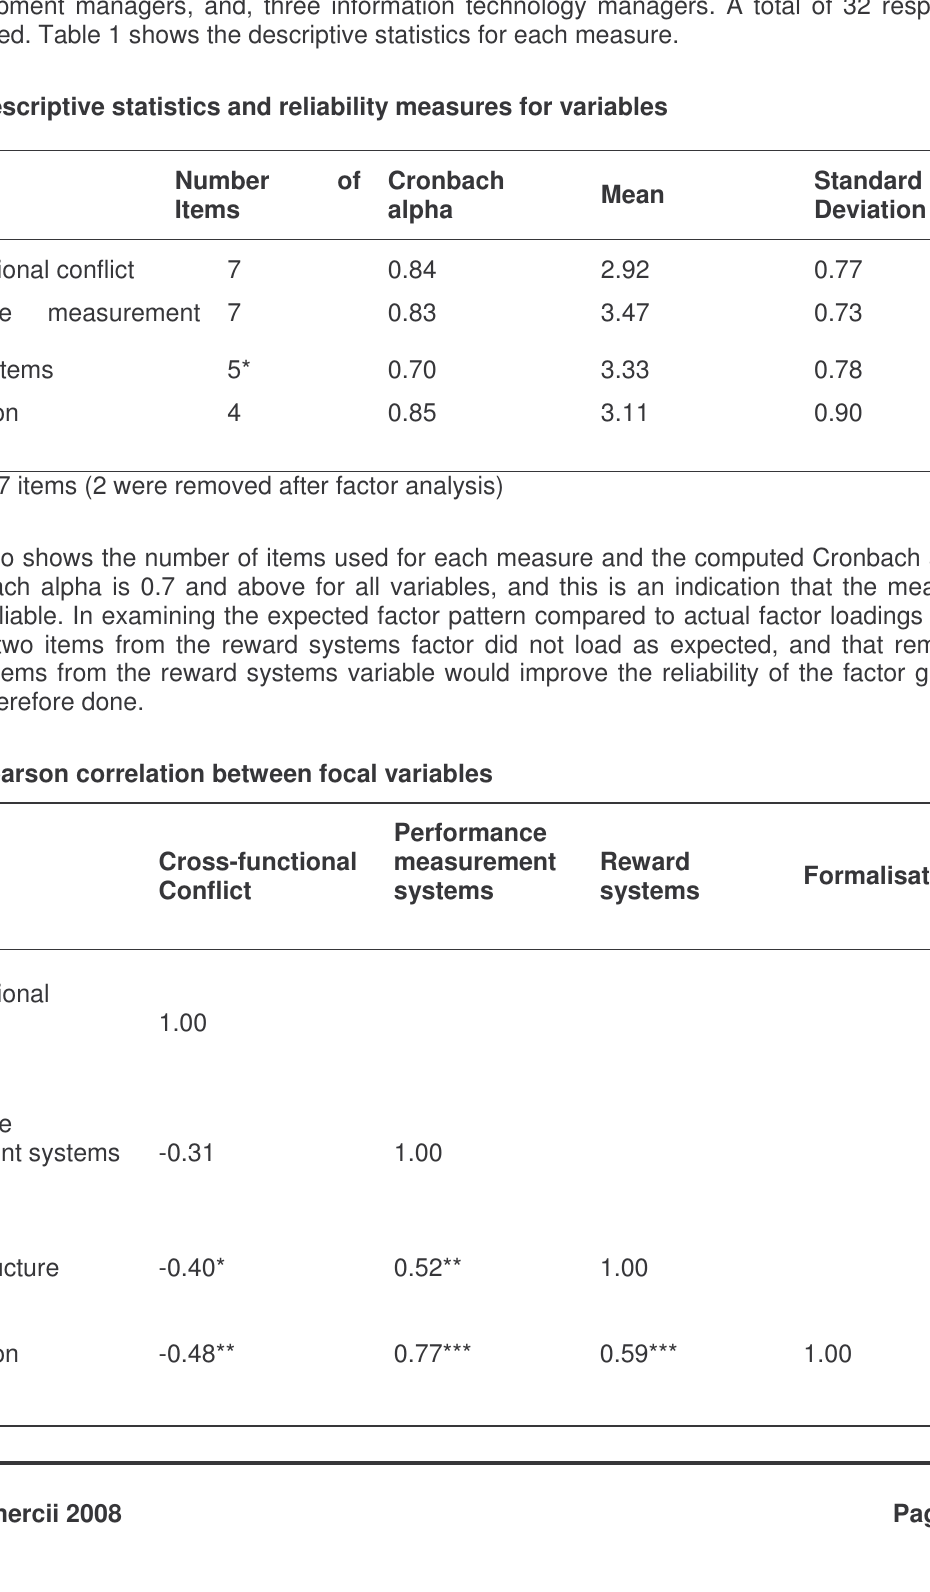
Table 1: Descriptive statistics and reliability measures for variables